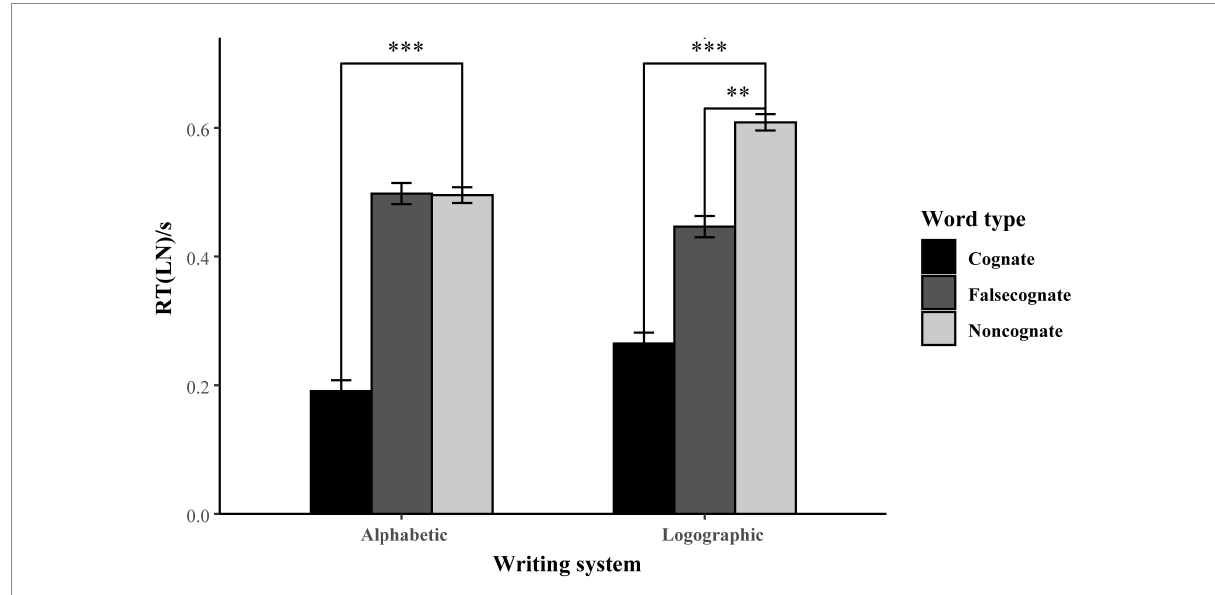
FIGURE 4 The alphabetic and logographic RTs for the cognate, false cognate and non-cognate in the recognition